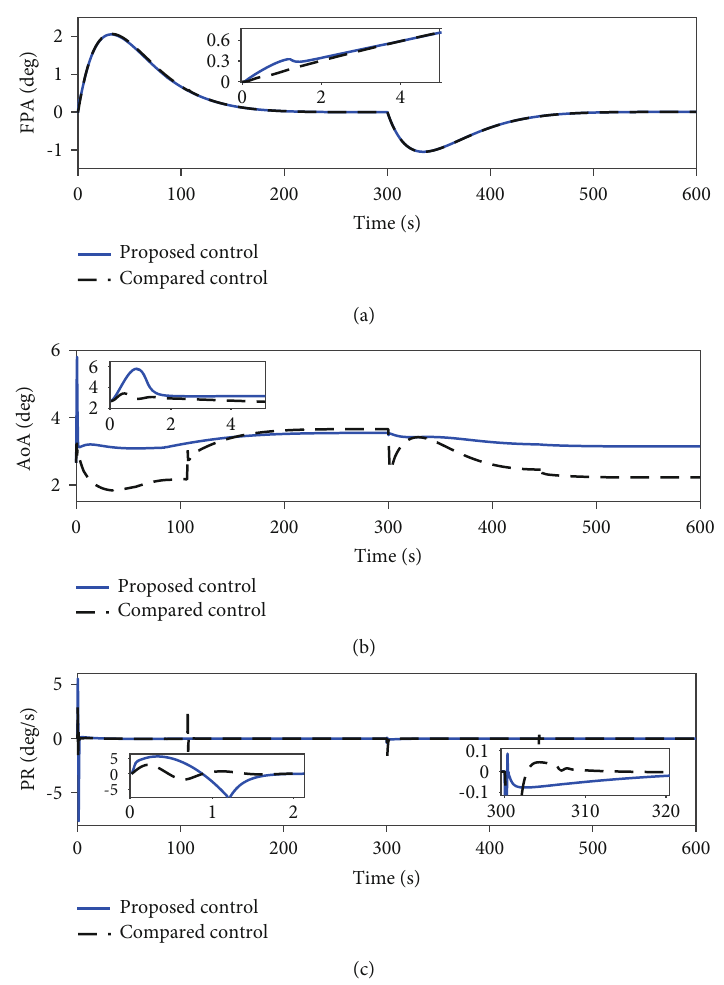
Figure 3: Flight attitudes in the comparison simulation: (a) fl ight path angle; (b) angle of attack; (c) pitch rate.